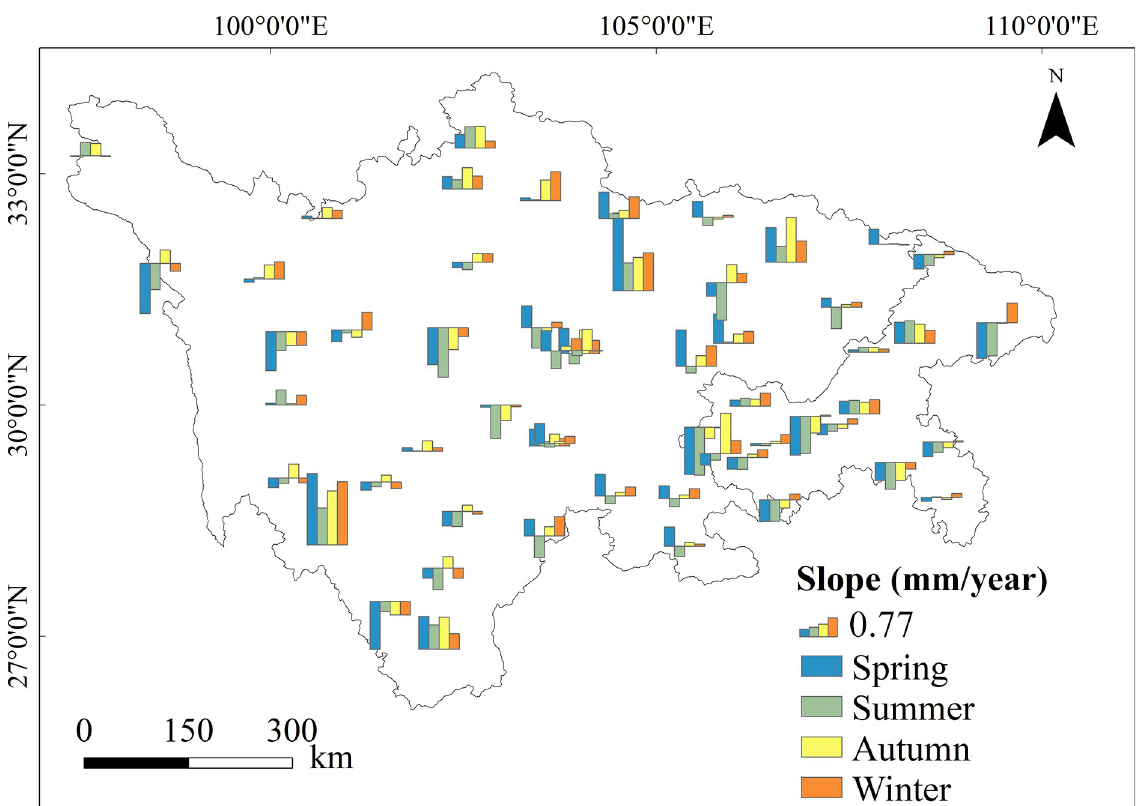
Fig 2. Seasonal trends of potential evapotranspiration at each station during 1970 − 2020. The columns are scaled according to the magnitude of the trend. The upward and downward columns denote increasing and decreasing tendencies, respectively.